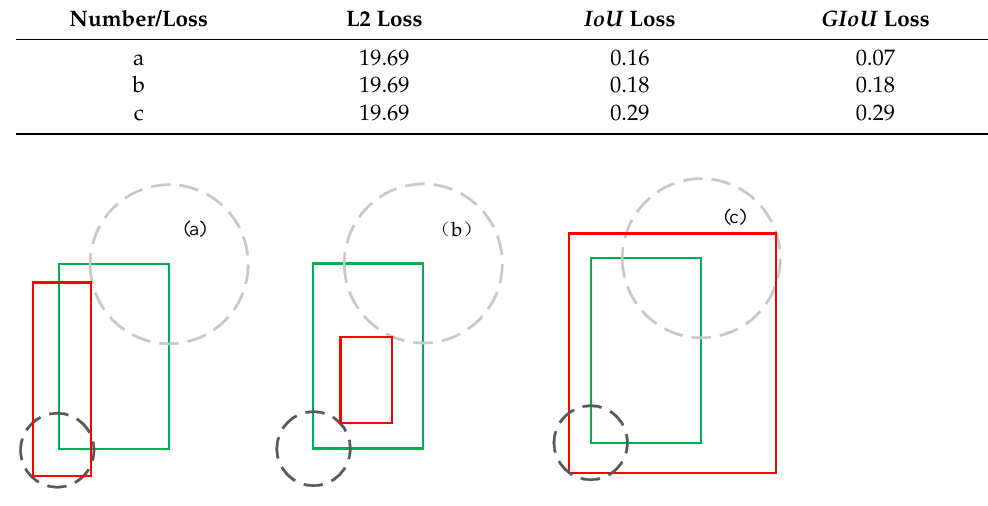
Figure 9. The comparison of L2 loss, IoU loss, and GIoU loss. ( a )The loss values of L2. ( b ) The loss values of IoU. ( c ) The loss value of GIoU .